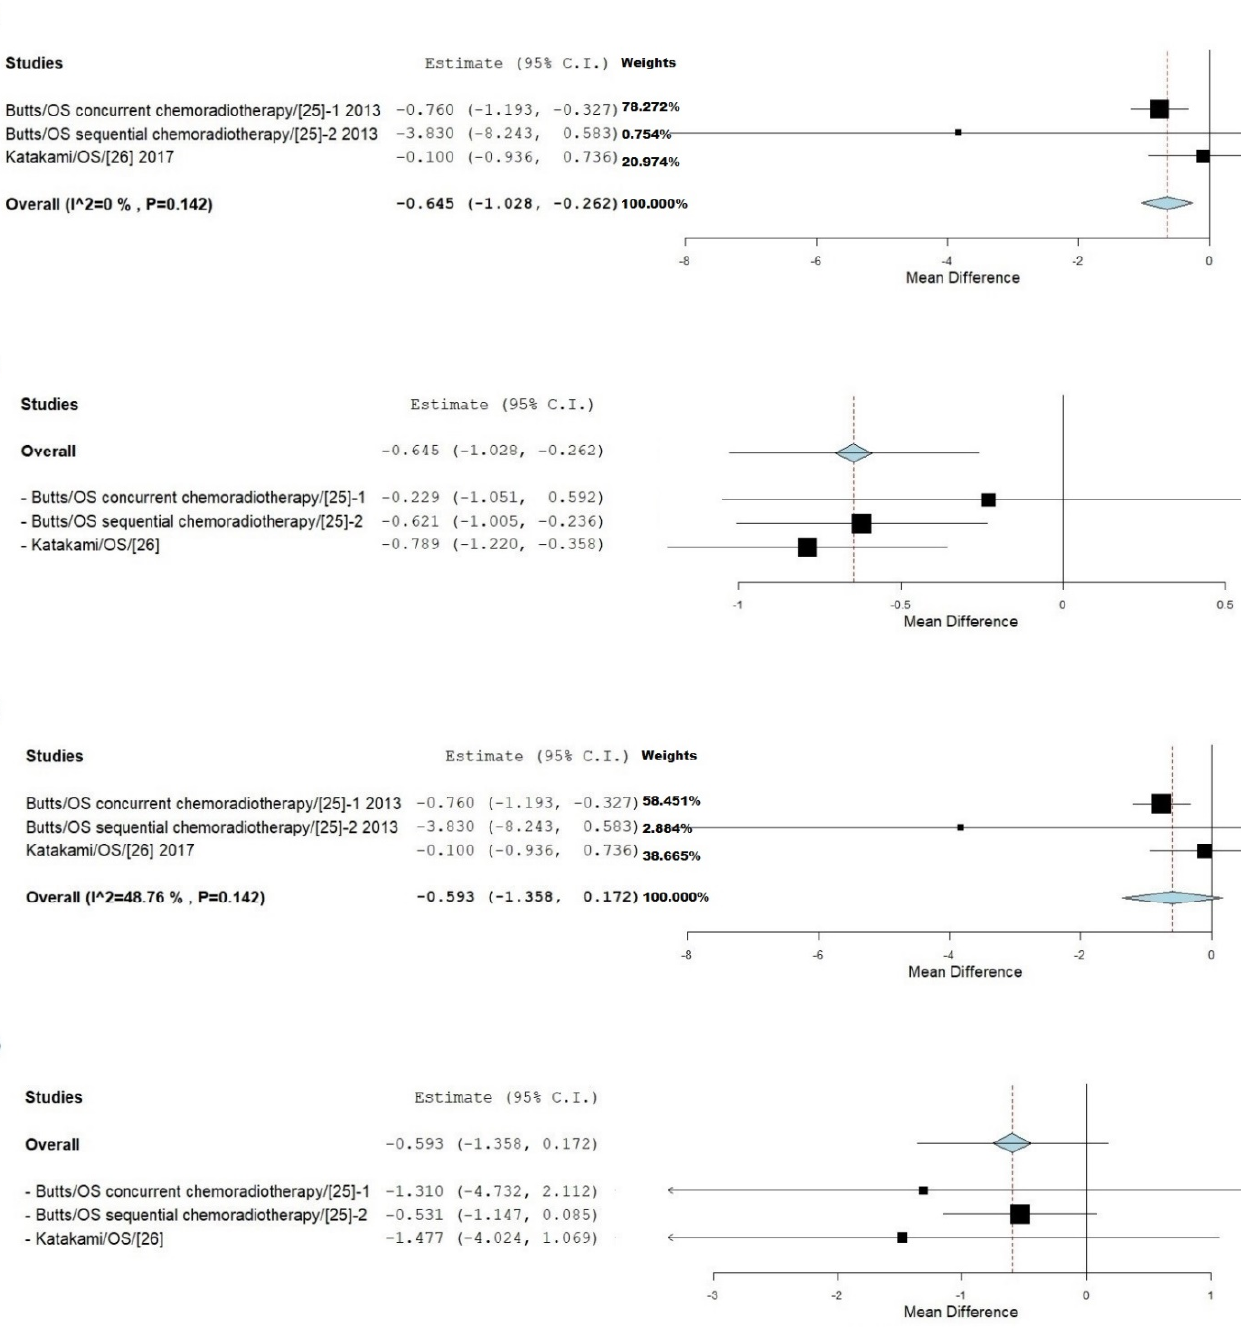
Figure 6. Meta-analysis of anti MUC1 drugs on NSCLC between smokers and non-smokers. ( A ) Shows results of FE with all sets of data. ( B ) Shows results of FE with leave-one-out model. ( C ) Shows results of RE with all sets of data. ( D ) Shows results of RE with leave-one out-model.